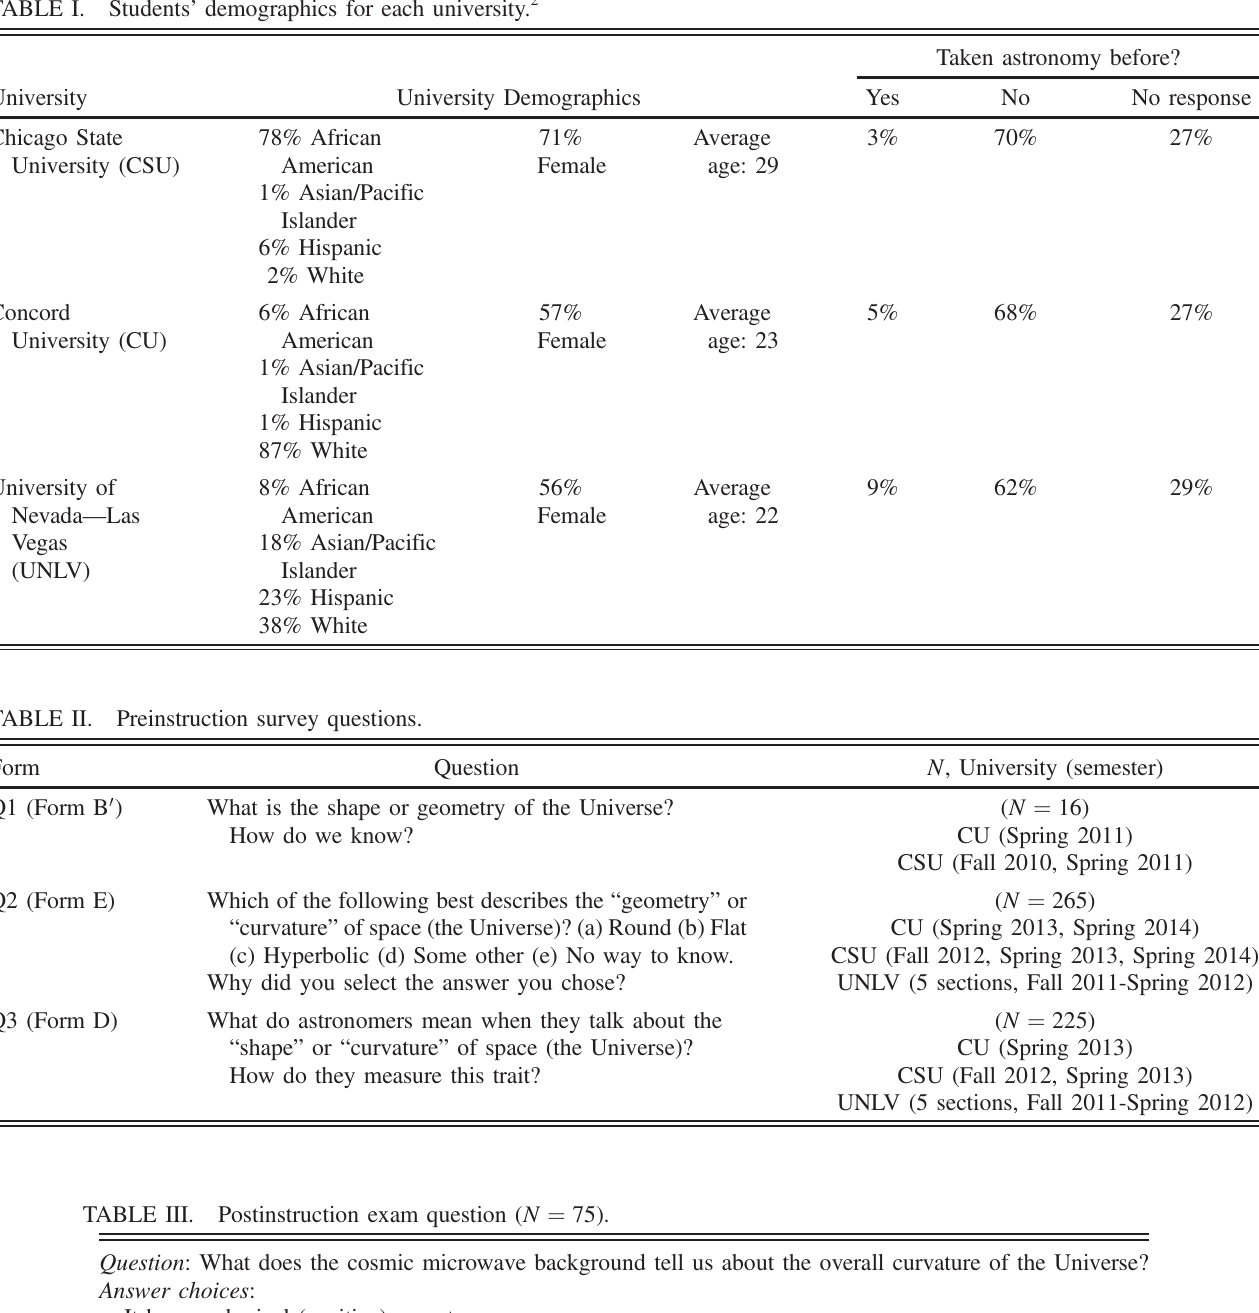
TABLE I. Students ’ demographics for each university. 2